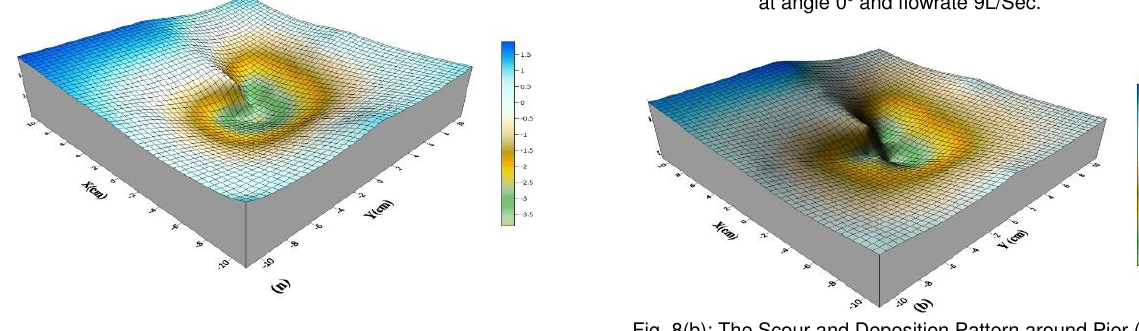
Fig. 7(n): The Scour and Deposition Pattern around Pier (P 1 ) at angle 19 0 and flowrate 14 L/Sec.